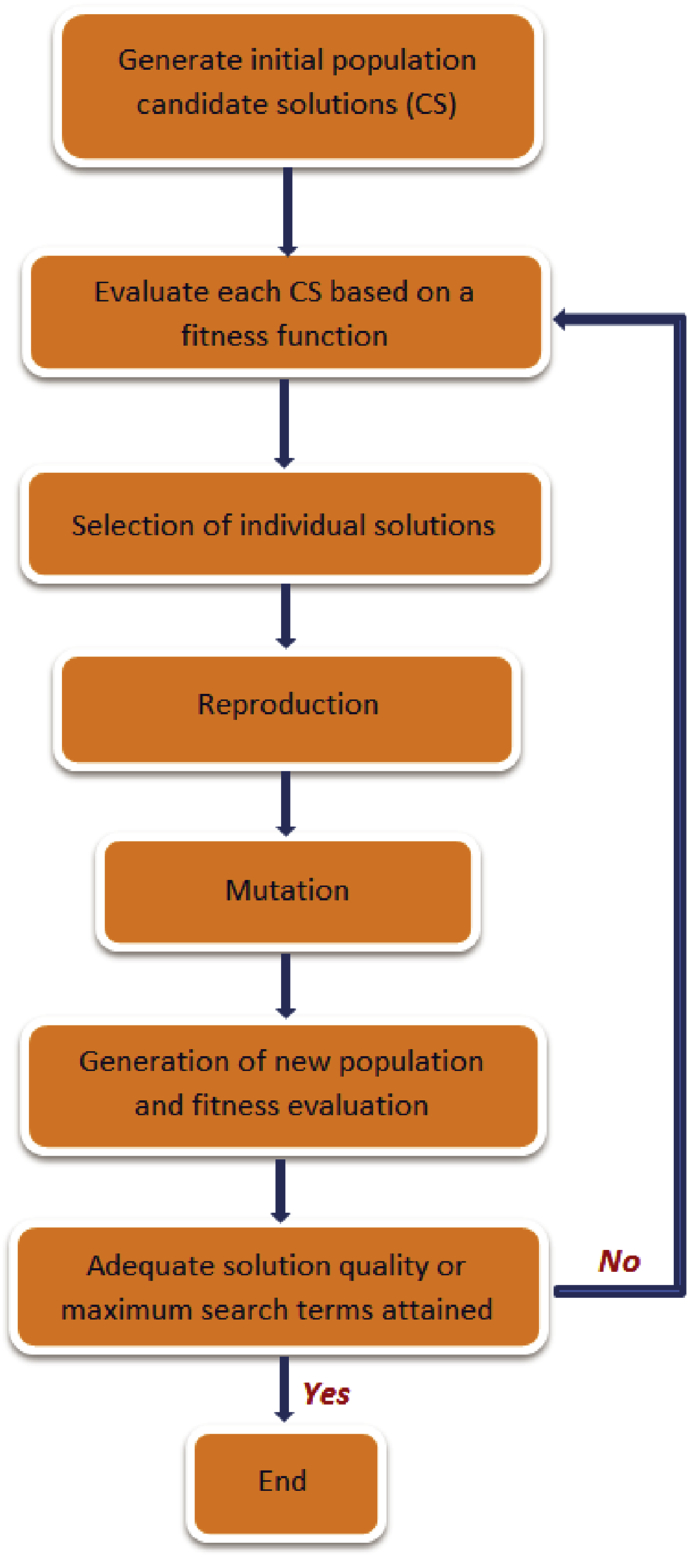
Fundamental methodologies for implementation of GA [Adapted from Nicklow et al. (2009)].